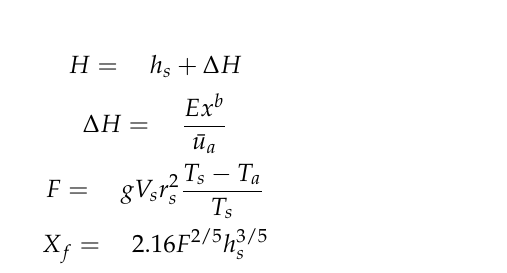
Table 6. Recompiled from various plume lift formulas expressed in the form ∆ H = Ex b